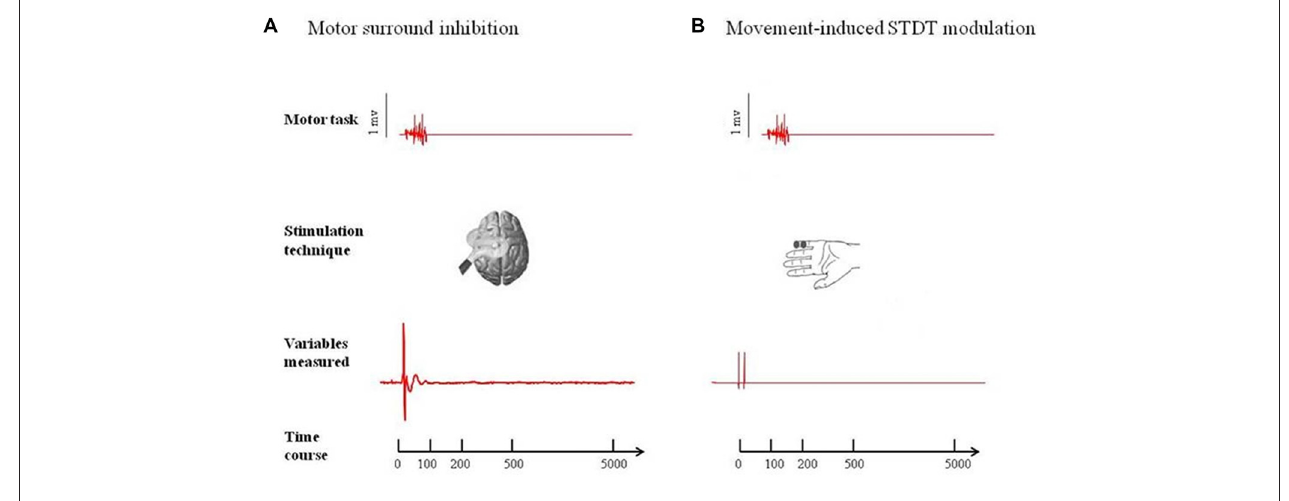
FIGURE 1 | Experimental paradigms. (A) Motor surround inhibition (mSI): transcranial magnetic stimulation (TMS) single pulses were delivered during a brief flexion of the right index finger performed at 10% of the maximum electromyography (EMG) activity after a “go” signal. Motor evoked potentials (MEPs) were recorded from abductor digiti minimi (ADM; “surround muscle”) and first dorsal interosseous (FDI; “active muscle”) at 0 ms, 100 ms, 200 ms, 500 ms and 5 s after movement onset. (B) Movement induced-somatosensory temporal discrimination threshold (STDT) modulation: pairs of electrical stimuli were delivered on the volar surface of the right digiti minimi at 0 ms, 100 ms, 200 ms, 500 ms and 5 safter right index finger flexion performed at 10% of the maximum EMG activity after a “go” signal. Note that the magnetic stimuli for mSI and the electric stimuli for STDT were both triggered when EMG activity above 100 µ V was detected in the right FDI (active muscle). mSI and movement induced-STDT modulation were evaluated in two distinct sessions performed on the same